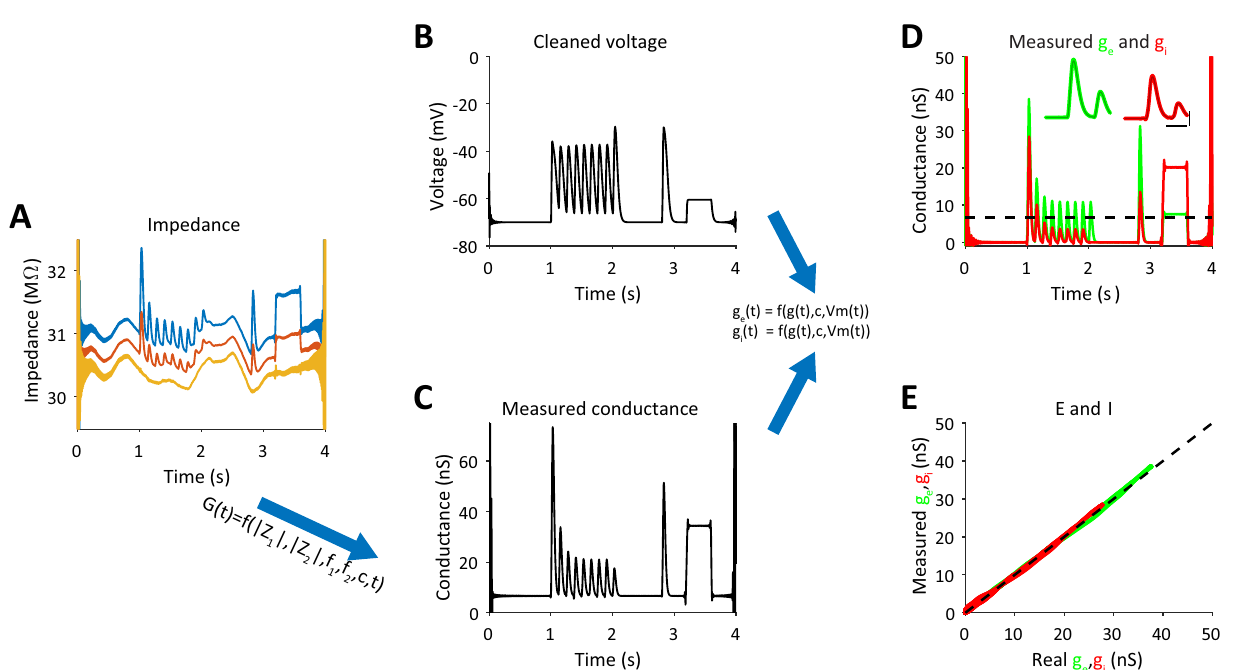
Fig 6. Measurements of g e and g i are accurate even when electrode resistance is not stable. A. Absolute impedance curves for each frequency depicted together with measured electrode resistance. To modulate the electrode resistance, we smoothed a lowpass Normally distributed noise signal and added it to a fixed resistance. All other parameters of the inputs are identical to those shown in Figs 3 and 4. B-E. Analysis of the voltage response of the point neuron as processed by the same way as shown in Figs 2 and 3. Note for the accurate estimates of g e and g i (compare to Fig 3B).